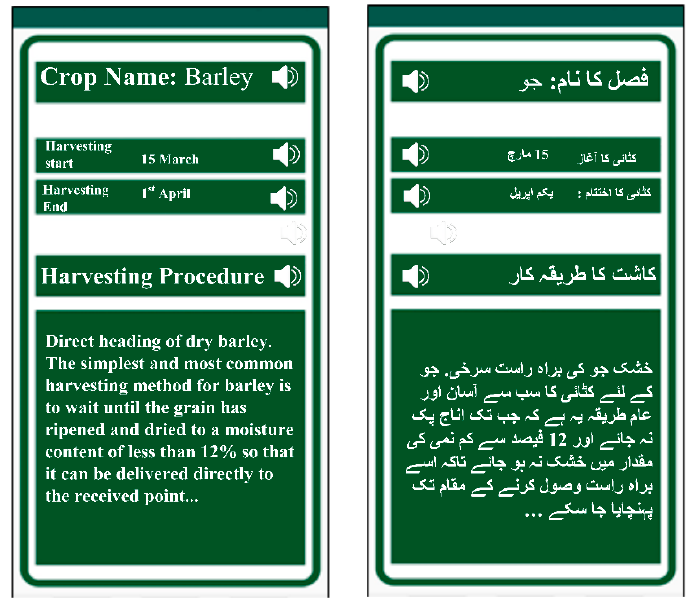
Figure 11. Harvesting and storing guidelines.